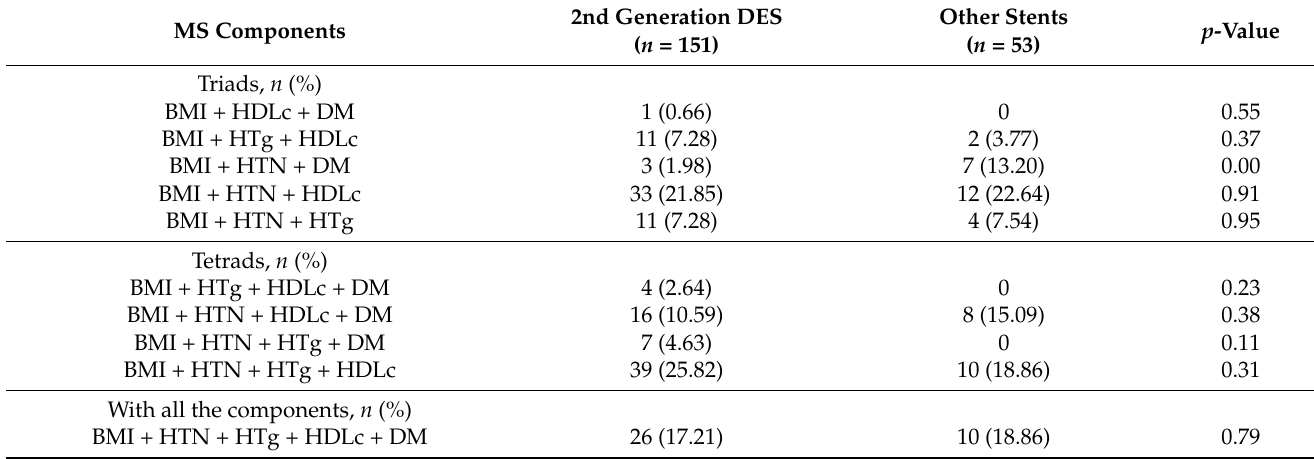
Table 2. Most frequent combinations of the metabolic syndrome components.